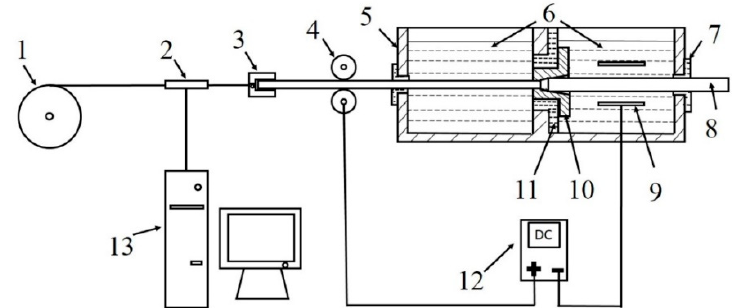
Figure 1. Schematic diagram of electrochemical cold drawing: (1) drawing roller; (2) sensor; (3) collet; (4) conductive wheels (anode); (5) electrolytic cell; (6) electrolyte solution; (7) rubber seal; (8) steel bar; (9) stainless steel sheet (cathode); (10) drawing die; (11) insulating mat; (12) DC power supply; (13) computer.